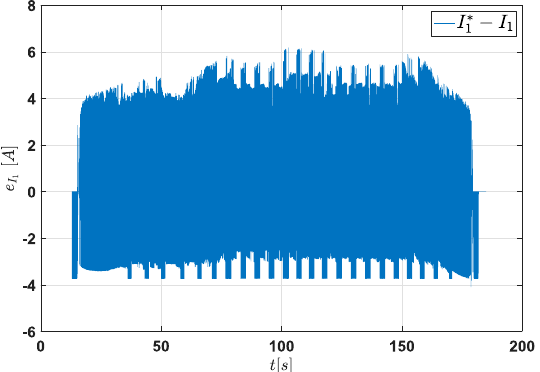
Figure 18. Current error response of phase 1 using PI control.